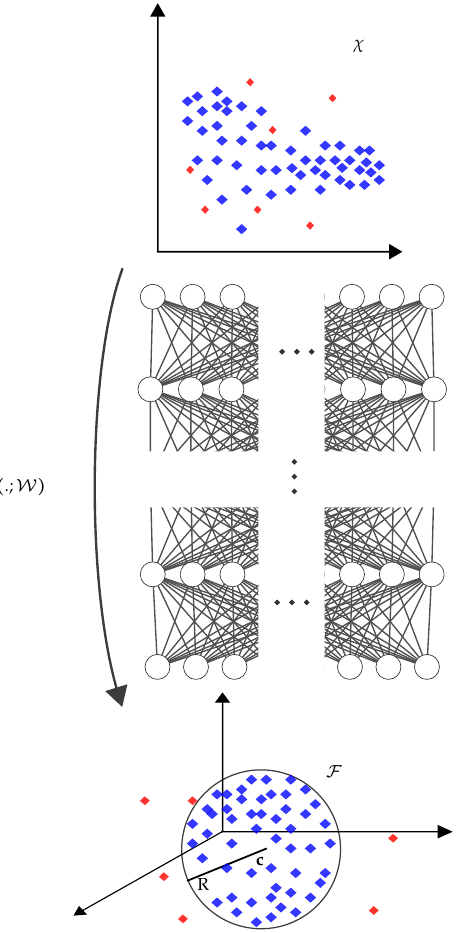
Figure 7. Deep SVDD maps most of the input data into a hypersphere specified by center c and radius R of a minimum volume using a neural network φ ( .; W) with weights W